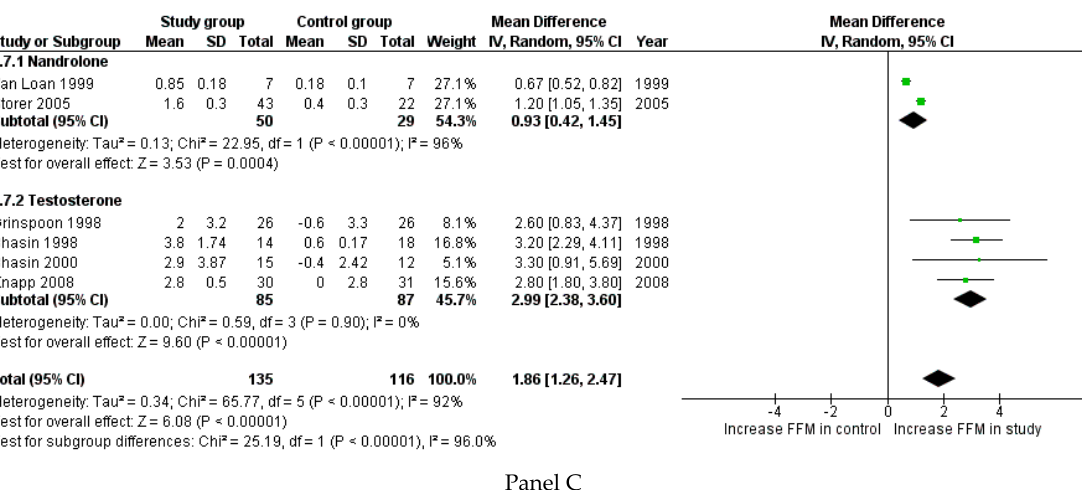
Figure 5. Forest plot comparing study and control groups detected in the second literature search, considering body weight change (WC) (kg) (Panel A ), lean body mass (LBM) (Panel B ), and fat free mass (FFM) change (Panel C ).